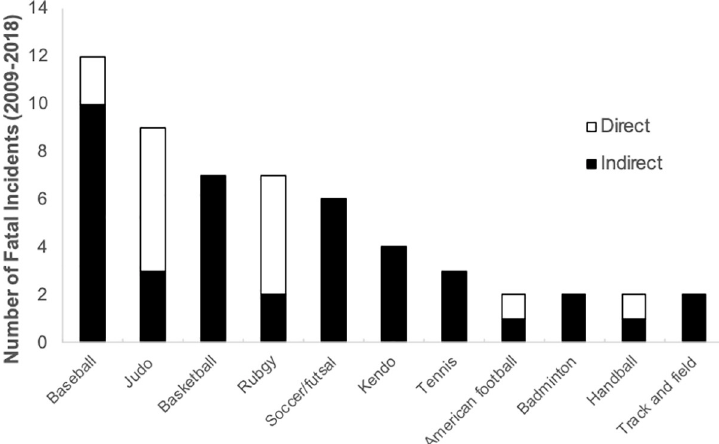
Fig 3. Number of fatalities reported to Japan Sport Council during organized high school sports between 2009 and 2018 in Japan by different sports and cause (direct vs.